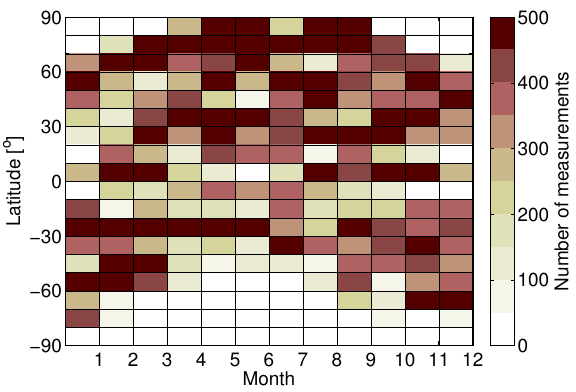
Figure 5. Number of GBL measurements as a function of latitude and time during 2004.